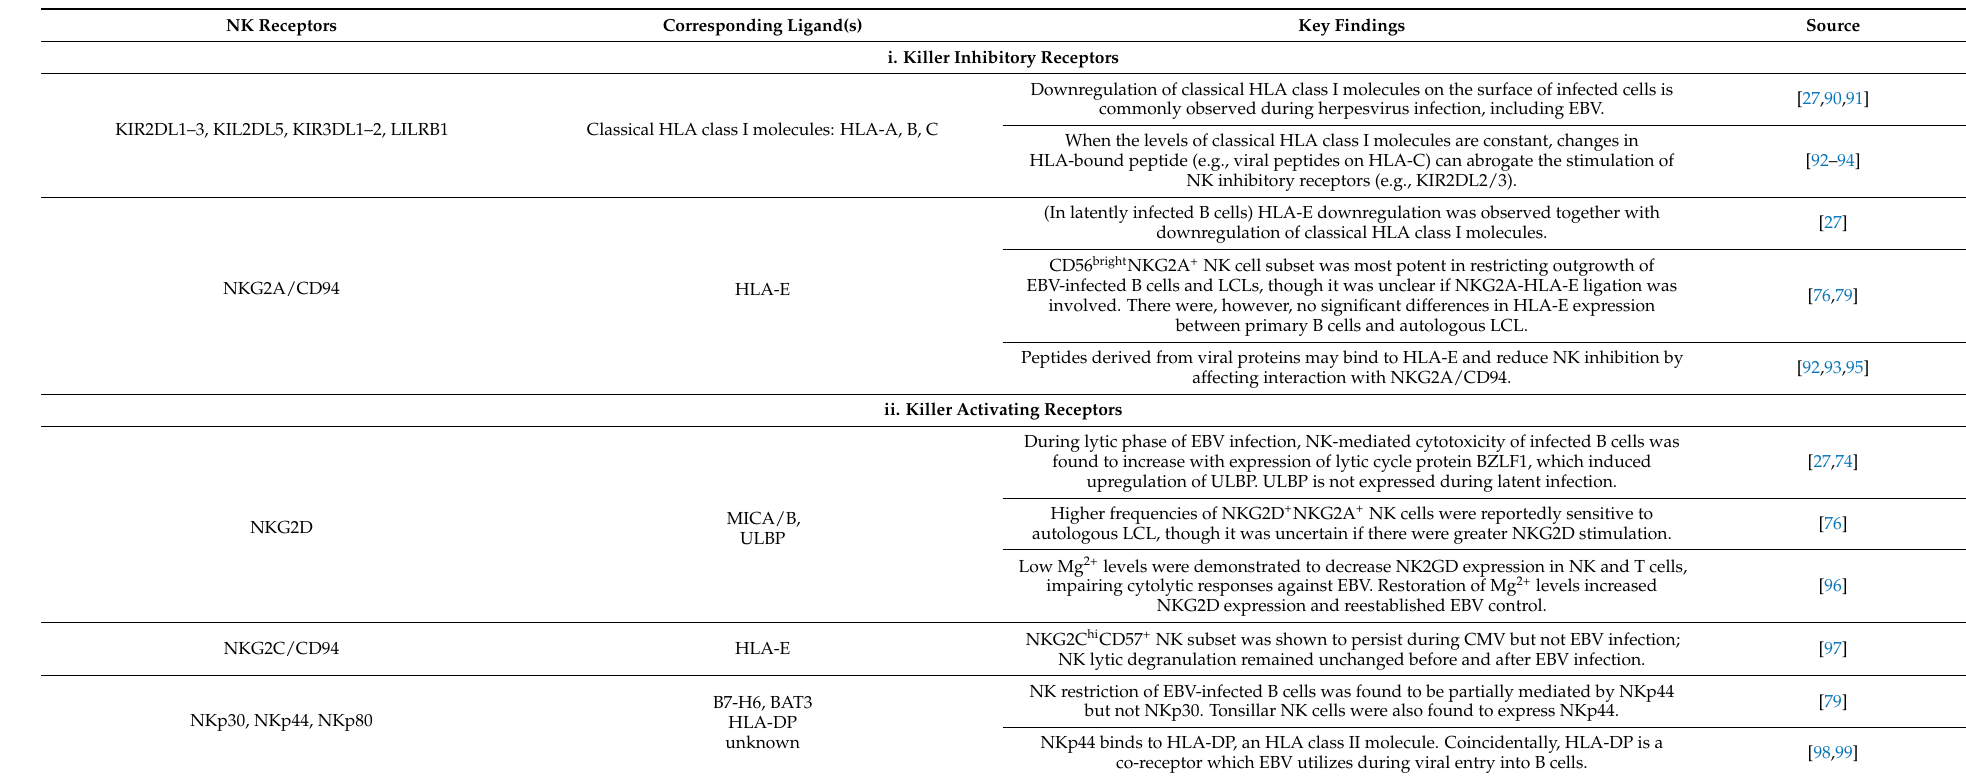
Table 1. Summary of receptor-ligand interactions affecting NK-mediated restriction of EBV